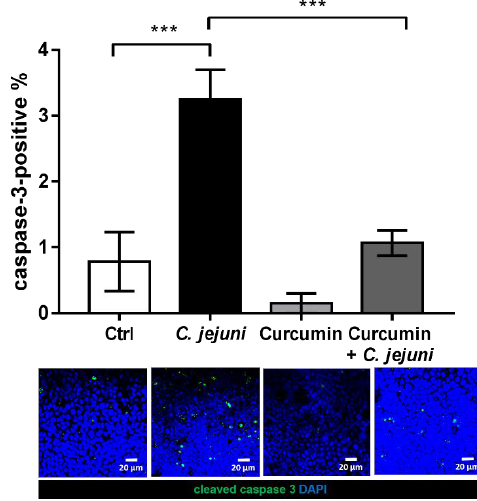
Figure 7. Apoptosis induction in C. jejuni -infected co-cultures. Cleaved caspase-3 staining